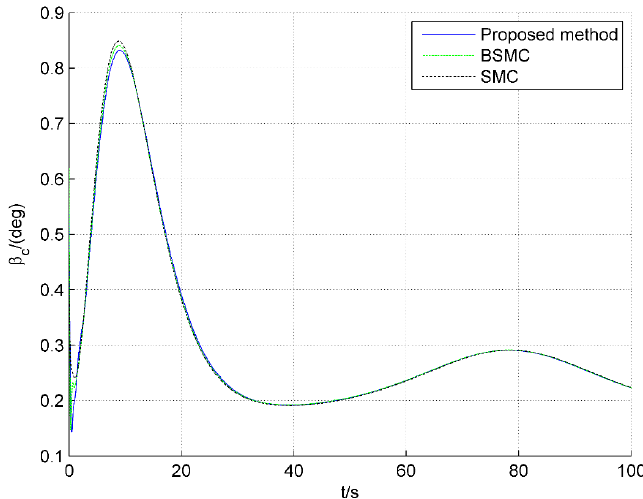
Figure 10. Responses of throttle setting.